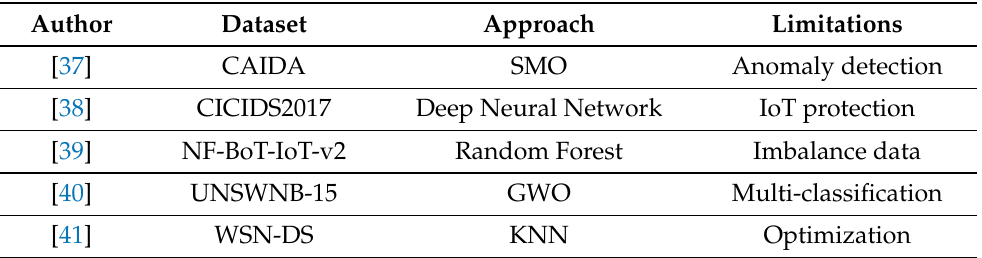
Table 1. A Comparative Analysis of related